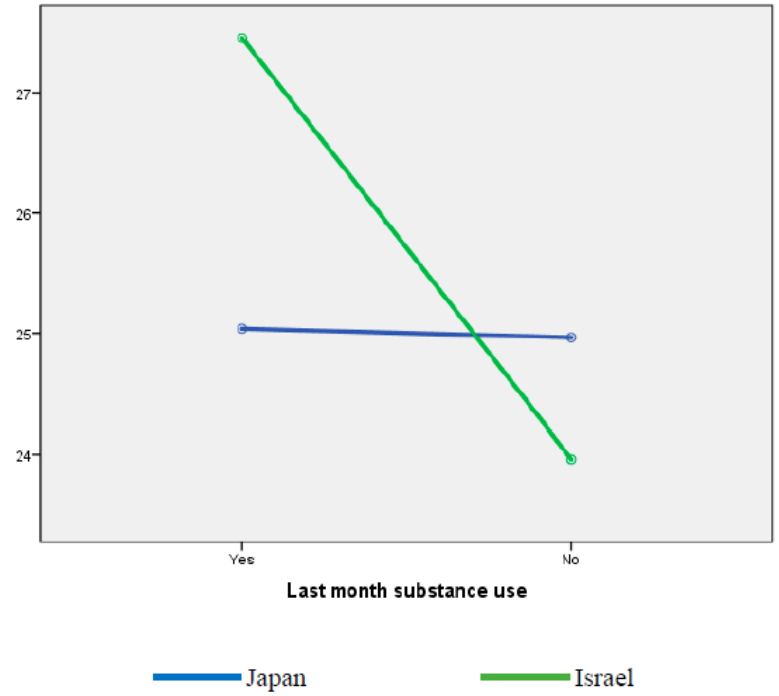
Figure 2. Economic concern by country and substance use in the previous month.